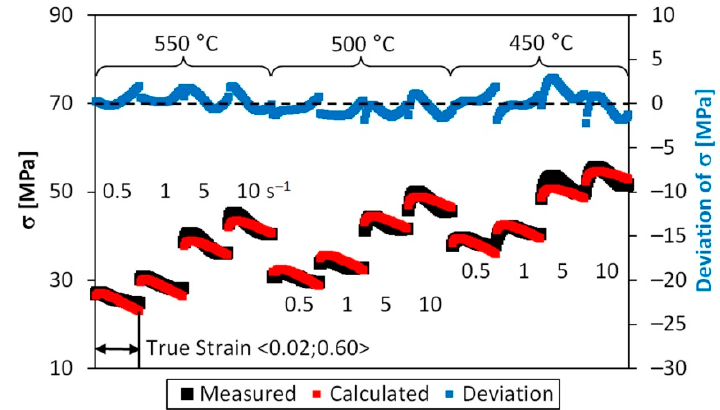
Figure 14. Graphical evaluation of the accuracy of the flow stress prediction according to Equation (7).